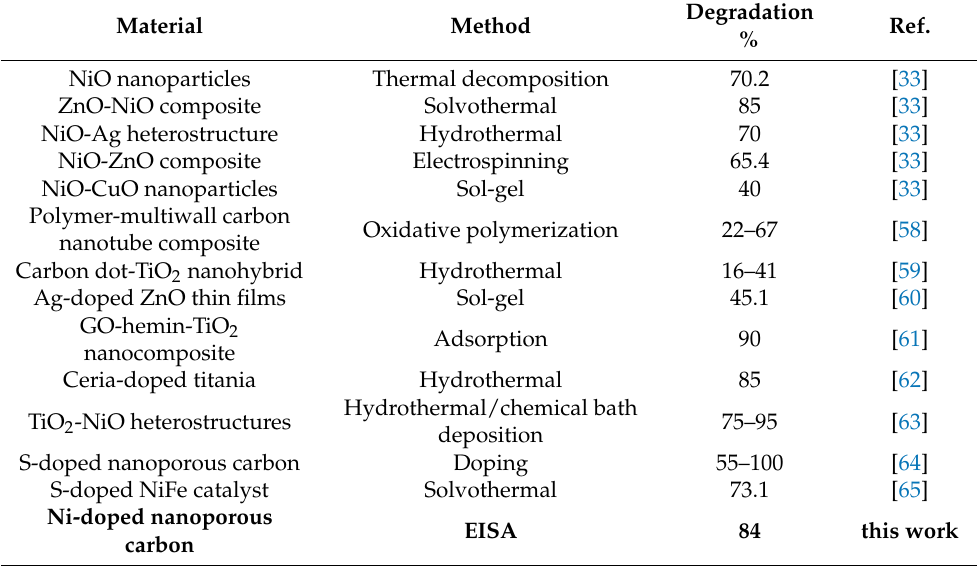
Table 3. Percent degradation of MB under visible light for various types of materials.